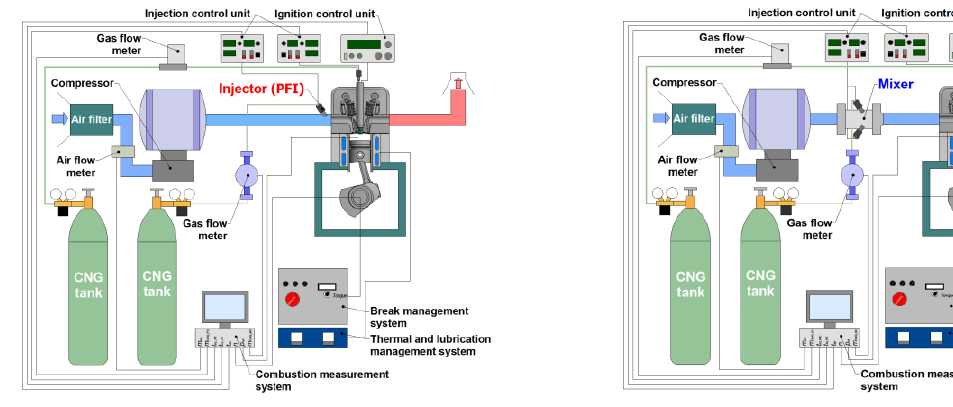
Fig. 2. Schematic of single cylinder engine test stand with port fuel injection system (PFI)